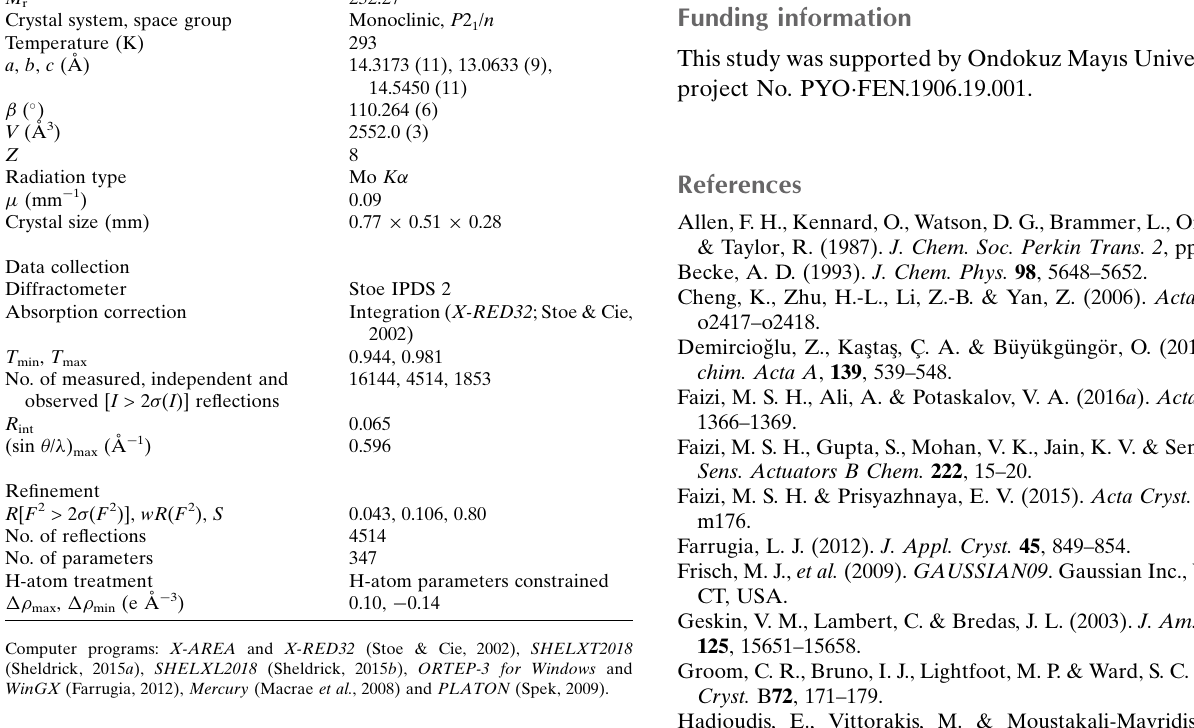
Table 2 Experimental details. Crystal data Chemical